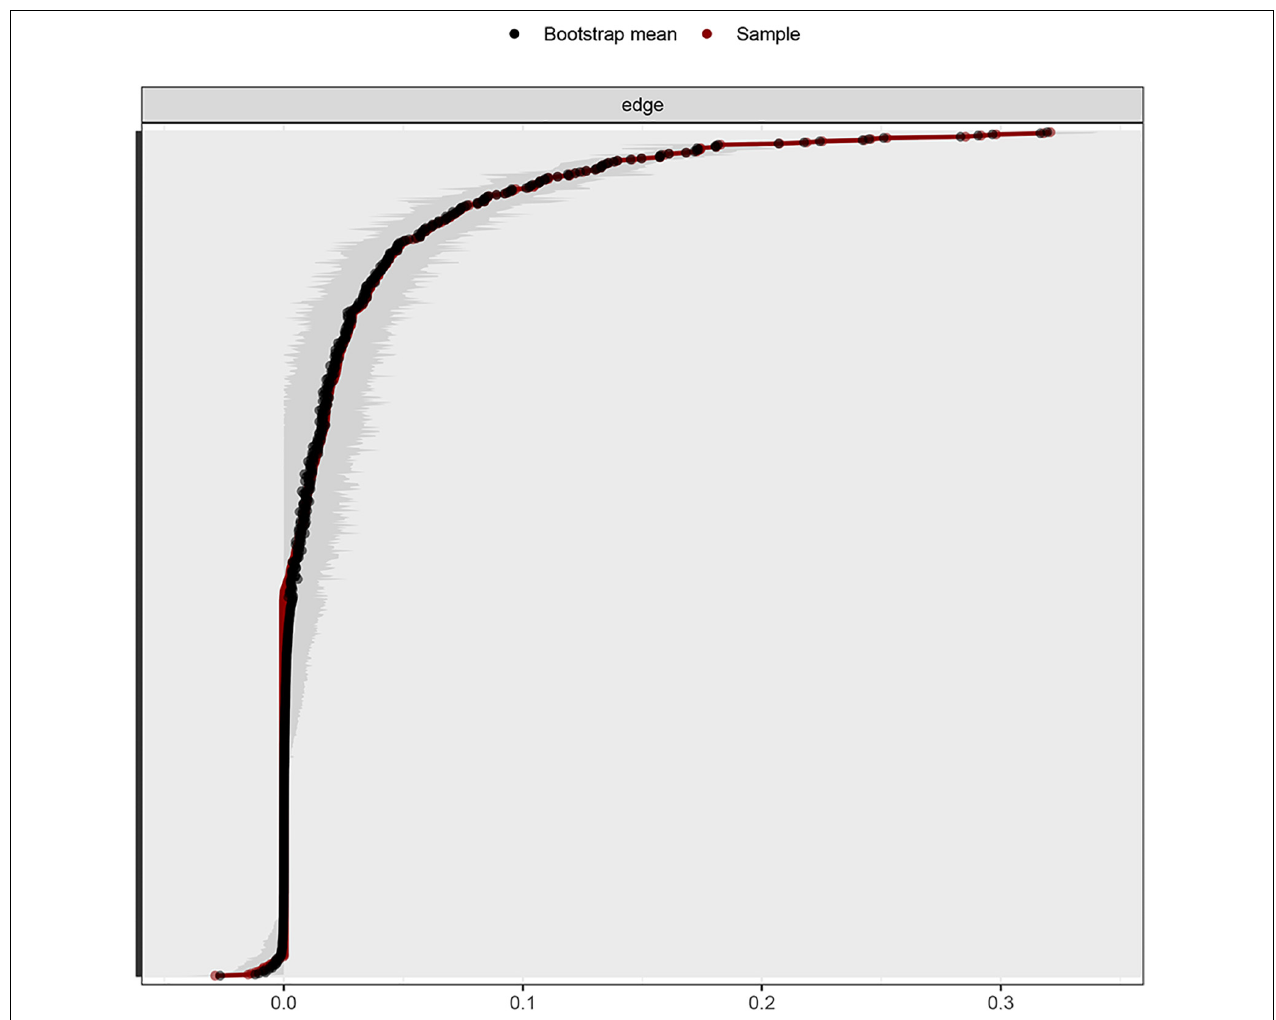
FIGURE 3 | Non-parametric bootstrapped CIs of estimated edges for abuse events and depression